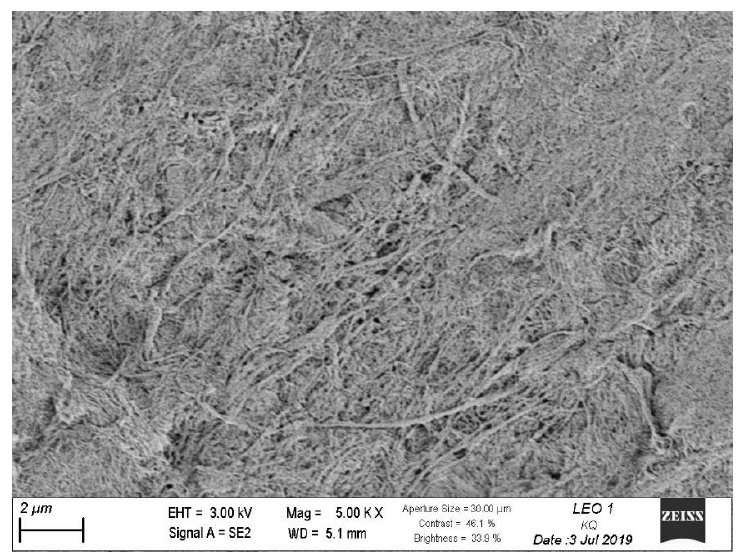
Figure 1. Scanning Electron Micrograph of CNF.